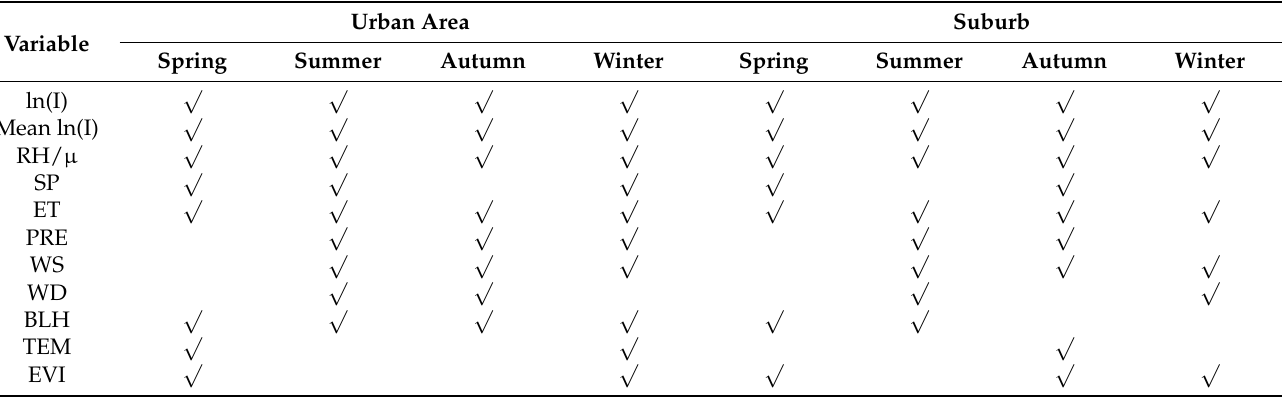
Table 4. The variables selected for modeling each season in the urban area and in the